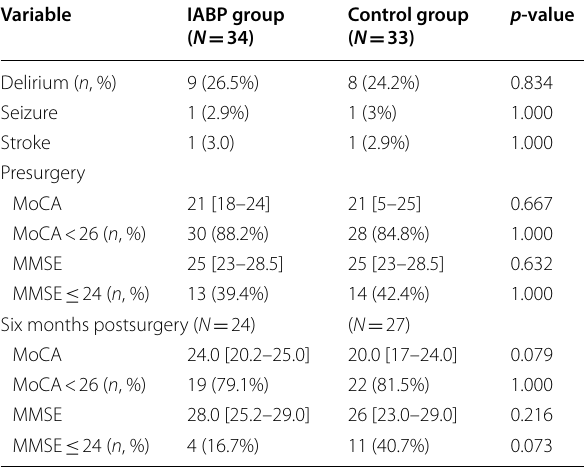
Table 4 Occurrence of neurological